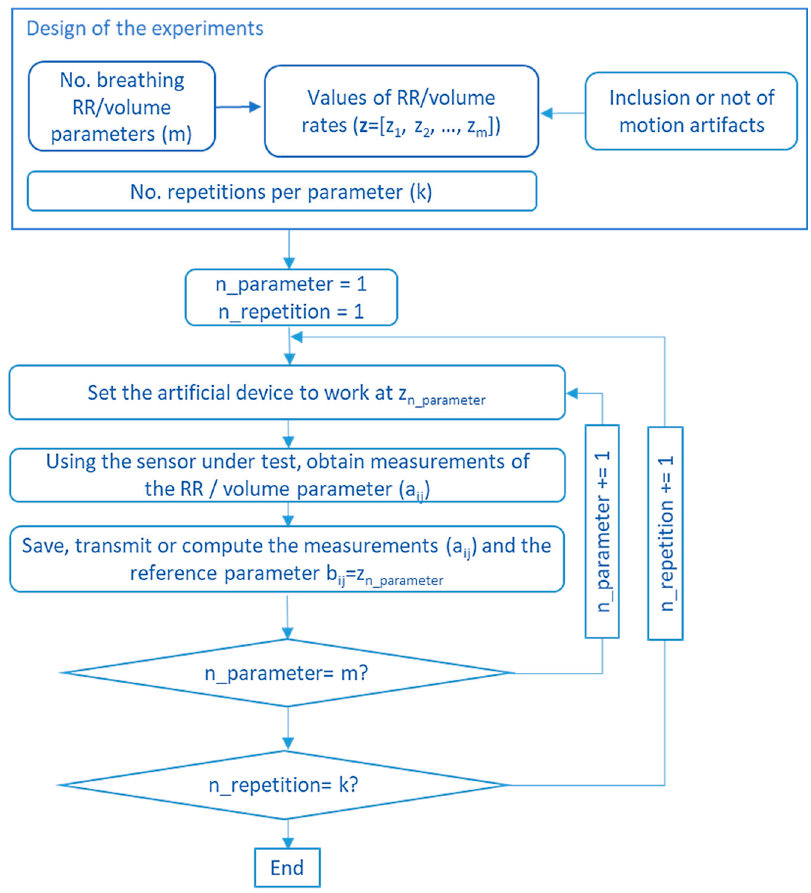
Figure 26. Flow diagram of a typical validation procedure using artificial prototypes.